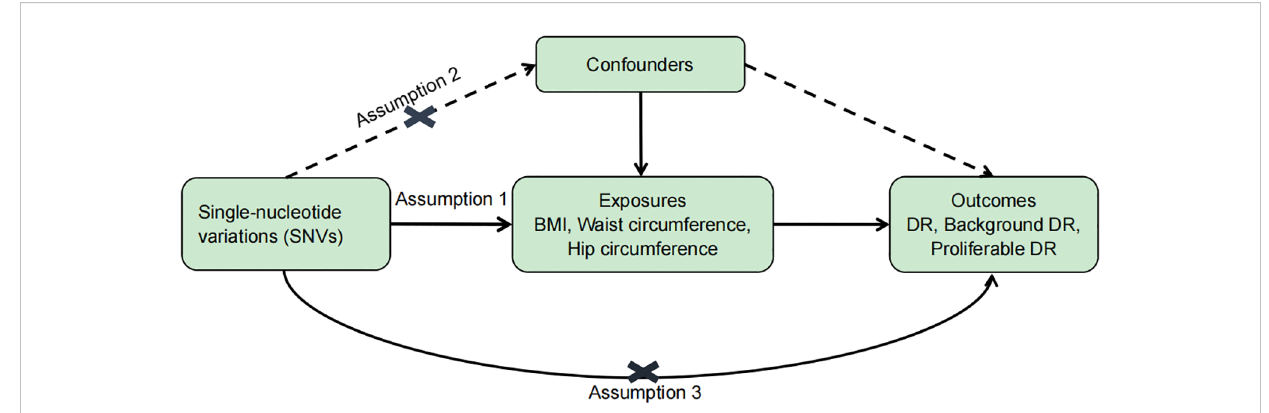
FIGURE 1 Basic assumptions of Mendelian randomization. Assumption 1: SNVs were closely associated with exposure. Assumption 2: SNVs were not associated with any potential confounders. Assumption 3: SNVs are only linked to the outcome through